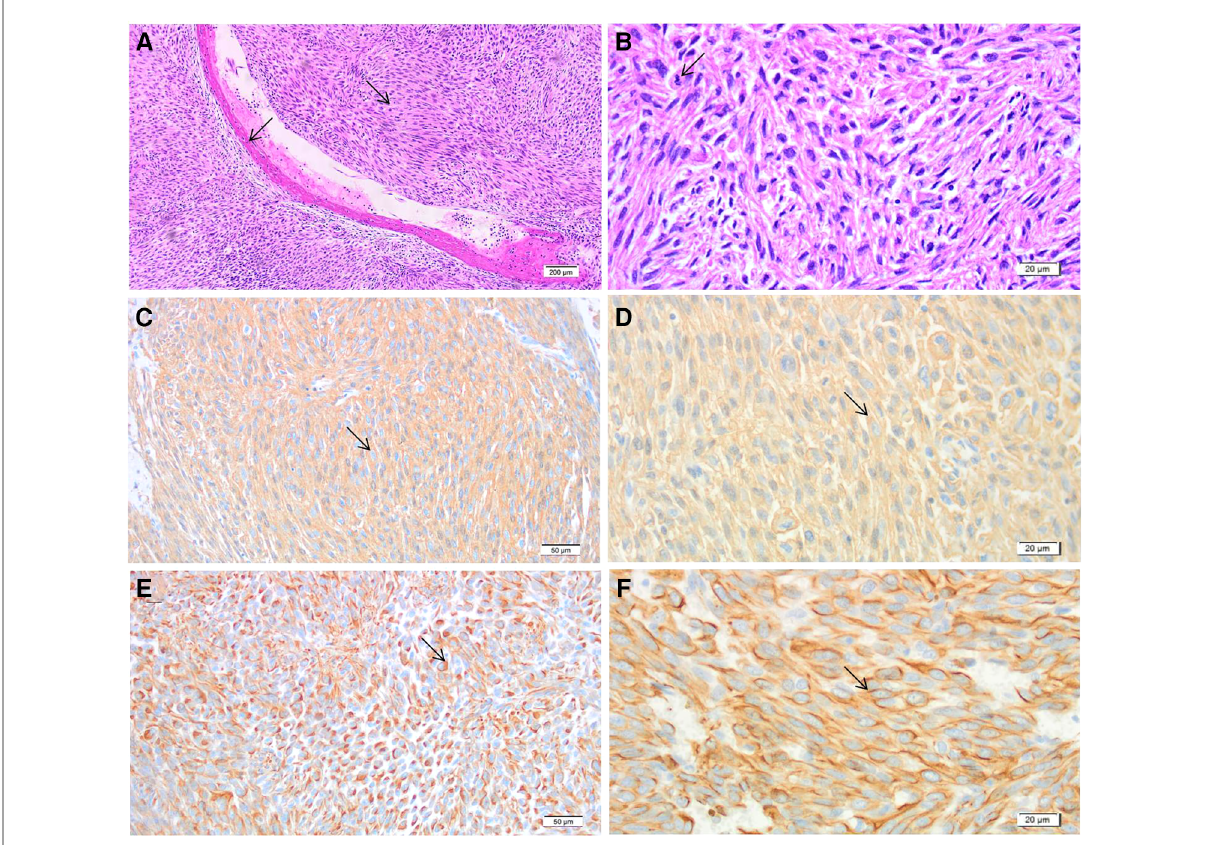
FIGURE 3 Results of postoperative pathological examination of the bone tumor. ( A ) Hematoxylin and eosin staining 40×: fusiform cell diffuse hyperplasia and tumor cells in fi ltrate adjacent bone trabeculae, as indicated by the arrow. In fl ammation is observed around the bone trabeculae. ( B ) Hematoxylin and eosin staining 400×: fusiform cell diffuse hyperplasia with a myxohyaline matrix pervading the intercellular space, as indicated by the arrow. ( C ) Smooth muscle actin 200×: cytoplasmic staining is diffuse and strongly positive, as indicated by the arrow. ( D ) Smooth muscle actin 400×: cytoplasmic staining is diffuse and strongly positive, as indicated by the arrow. ( E ) Desmin 200×: some cytoplasmic staining is positive, as indicated by the arrow. ( F ) Desmin 400×: some cytoplasmic staining is positive, as indicated by the